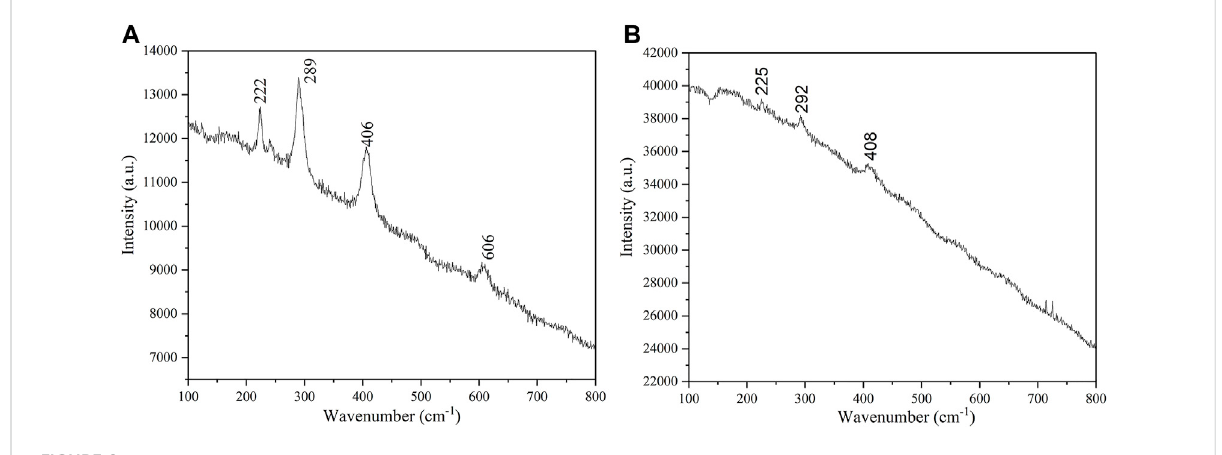
FIGURE 2 Raman results of sample QSM2-12 (A) and QSM1-16a (B)